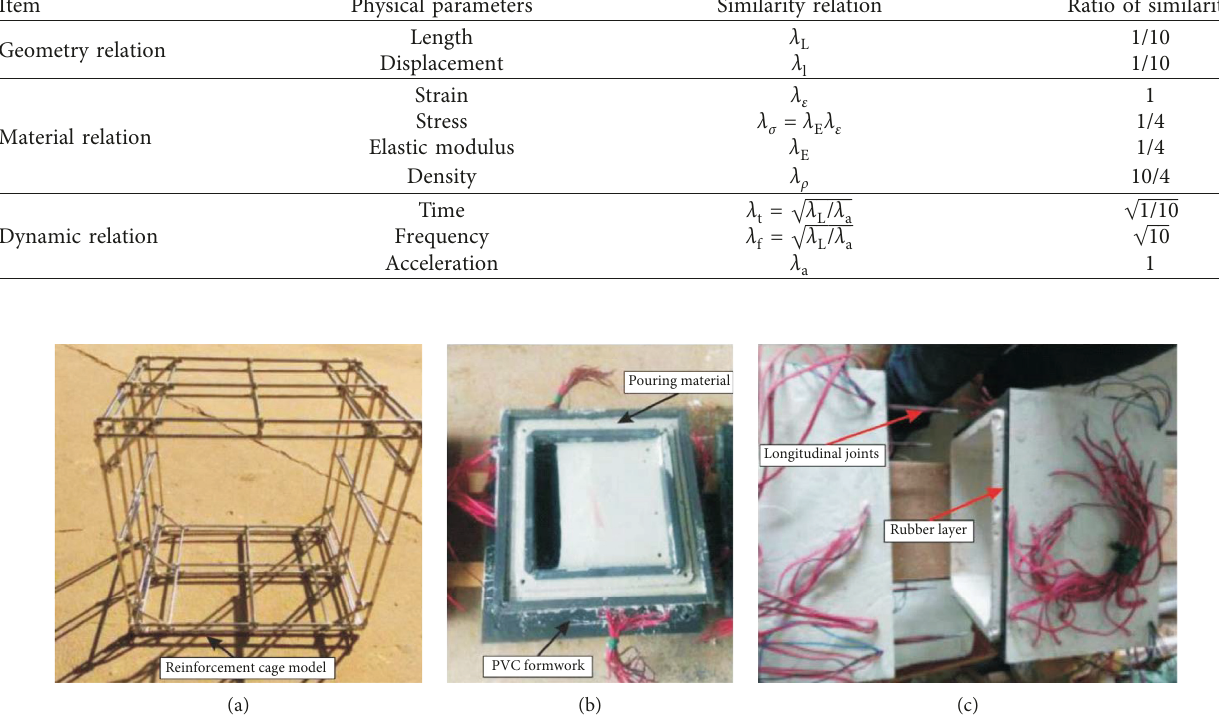
Figure 2: Manufacture of the utility tunnel model: (a) reinforcement cage model; (b) pouring of segment; (c) assembling of segments.